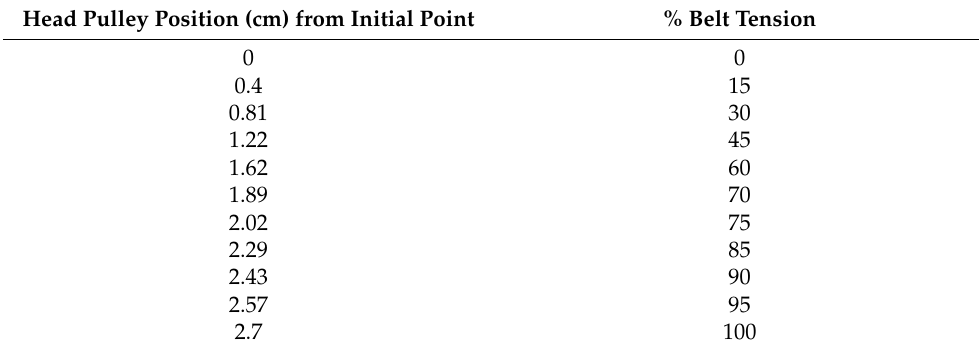
Table 3. Head pulley position and % belt